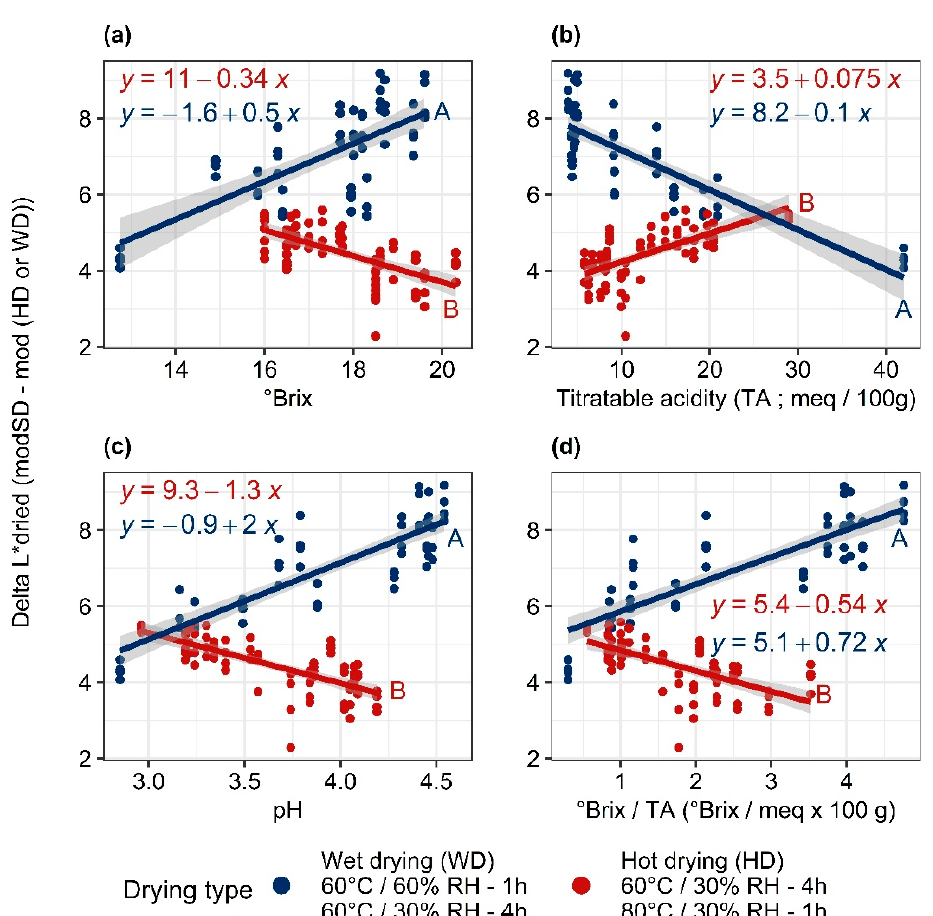
Figure 3. Regressions of ∆ L* as a function of physicochemical indices ( ◦ Brix ( a ), titratable acidity: TA ( b ), pH ( c ), ◦ Brix/titratable acidity ( d )) under wet and hot drying procedures. Solid lines with grey envelopes: regression lines with 95% confidence intervals. Different letters indicate significantly different regression lines at 5% threshold.